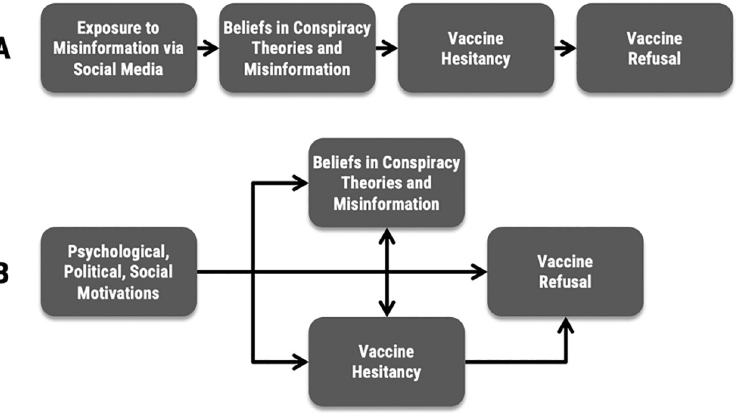
Fig 1. Two conceptual models of relationship between beliefs in COVID-19 conspiracy theories and misinformation and vaccine hesitancy and refusal.